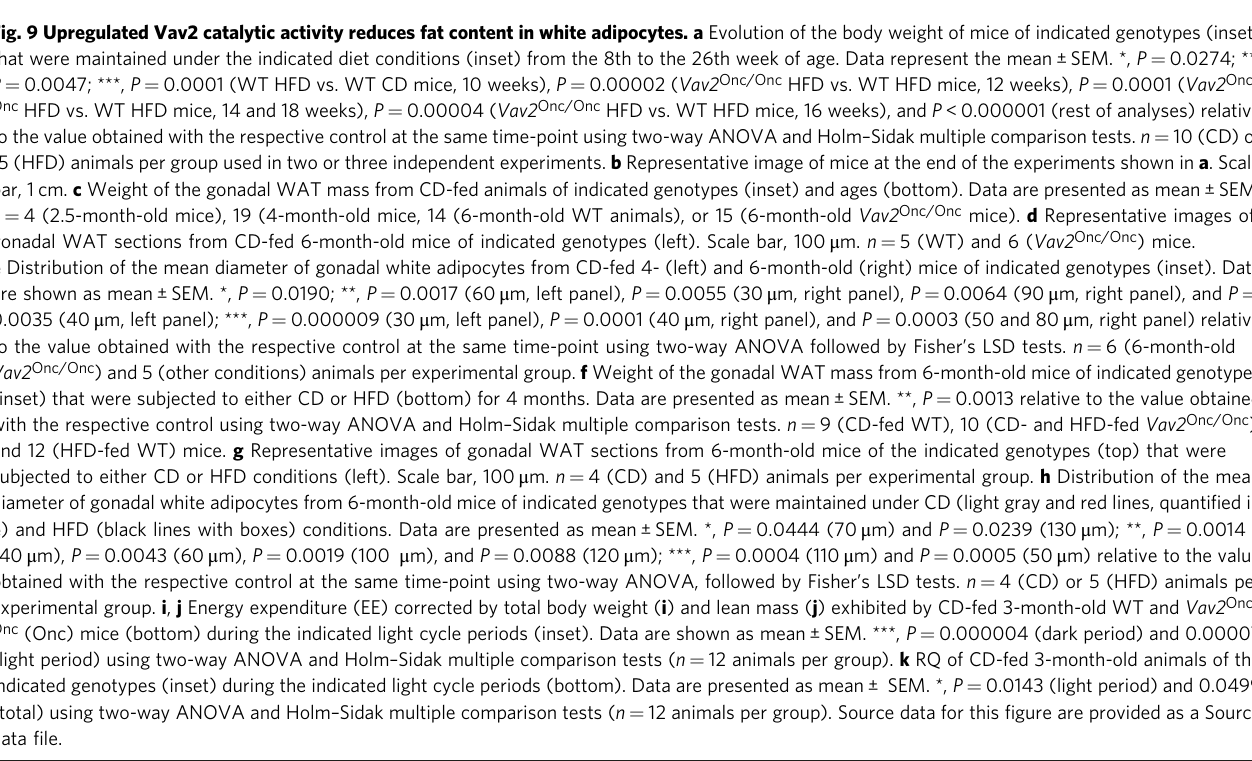
Fig. 9 Upregulated Vav2 catalytic activity reduces fat content in white adipocytes. a Evolution of the body weight of mice of indicated genotypes (inset) that were maintained under the indicated diet conditions (inset) from the 8th to the 26th week of age. Data represent the mean ± SEM. *, P = 0.0274; **, P = 0.0047; ***, P = 0.0001 (WT HFD vs. WT CD mice, 10 weeks), P = 0.00002 ( Vav2 Onc/Onc HFD vs. WT HFD mice, 12 weeks), P = 0.0001 ( Vav2 Onc/ Onc HFD vs. WT HFD mice, 14 and 18 weeks), P = 0.00004 ( Vav2 Onc/Onc HFD vs. WT HFD mice, 16 weeks), and P < 0.000001 (rest of analyses) relative to the value obtained with the respective control at the same time-point using two-way ANOVA and Holm – Sidak multiple comparison tests. n = 10 (CD) or 15 (HFD) animals per group used in two or three independent experiments. b Representative image of mice at the end of the experiments shown in a . Scale bar, 1 cm. c Weight of the gonadal WAT mass from CD-fed animals of indicated genotypes (inset) and ages (bottom). Data are presented as mean ± SEM. n = 4 (2.5-month-old mice), 19 (4-month-old mice, 14 (6-month-old WT animals), or 15 (6-month-old Vav2 Onc/Onc mice). d Representative images of gonadal WAT sections from CD-fed 6-month-old mice of indicated genotypes (left). Scale bar, 100 μ m. n = 5 (WT) and 6 ( Vav2 Onc/Onc ) mice. e Distribution of the mean diameter of gonadal white adipocytes from CD-fed 4- (left) and 6-month-old (right) mice of indicated genotypes (inset). Data are shown as mean ± SEM. *, P = 0.0190; **, P = 0.0017 (60 μ m, left panel), P = 0.0055 (30 μ m, right panel), P = 0.0064 (90 μ m, right panel), and P = 0.0035 (40 μ m, left panel); ***, P = 0.000009 (30 μ m, left panel), P = 0.0001 (40 μ m, right panel), and P = 0.0003 (50 and 80 μ m, right panel) relative to the value obtained with the respective control at the same time-point using two-way ANOVA followed by Fisher ’ s LSD tests. n = 6 (6-month-old Vav2 Onc/Onc ) and 5 (other conditions) animals per experimental group. f Weight of the gonadal WAT mass from 6-month-old mice of indicated genotypes (inset) that were subjected to either CD or HFD (bottom) for 4 months. Data are presented as mean ± SEM. **, P = 0.0013 relative to the value obtained with the respective control using two-way ANOVA and Holm – Sidak multiple comparison tests. n = 9 (CD-fed WT), 10 (CD- and HFD-fed Vav2 Onc/Onc ), and 12 (HFD-fed WT) mice. g Representative images of gonadal WAT sections from 6-month-old mice of the indicated genotypes (top) that were subjected to either CD or HFD conditions (left). Scale bar, 100 μ m. n = 4 (CD) and 5 (HFD) animals per experimental group. h Distribution of the mean diameter of gonadal white adipocytes from 6-month-old mice of indicated genotypes that were maintained under CD (light gray and red lines, quanti fi ed in e ) and HFD (black lines with boxes) conditions. Data are presented as mean ± SEM. *, P = 0.0444 (70 μ m) and P = 0.0239 (130 μ m); **, P = 0.0014 (40 μ m), P = 0.0043 (60 μ m), P = 0.0019 (100 μ m), and P = 0.0088 (120 μ m); ***, P = 0.0004 (110 μ m) and P = 0.0005 (50 μ m) relative to the value obtained with the respective control at the same time-point using two-way ANOVA, followed by Fisher ’ s LSD tests. n = 4 (CD) or 5 (HFD) animals per experimental group. i , j Energy expenditure (EE) corrected by total body weight ( i ) and lean mass ( j ) exhibited by CD-fed 3-month-old WT and Vav2 Onc/ Onc (Onc) mice (bottom) during the indicated light cycle periods (inset). Data are shown as mean ± SEM. ***, P = 0.000004 (dark period) and 0.00007 (light period) using two-way ANOVA and Holm – Sidak multiple comparison tests ( n = 12 animals per group). k RQ of CD-fed 3-month-old animals of the indicated genotypes (inset) during the indicated light cycle periods (bottom). Data are presented as mean ± SEM. *, P = 0.0143 (light period) and 0.0499 (total) using two-way ANOVA and Holm – Sidak multiple comparison tests ( n = 12 animals per group). Source data for this fi gure are provided as a Source data fi